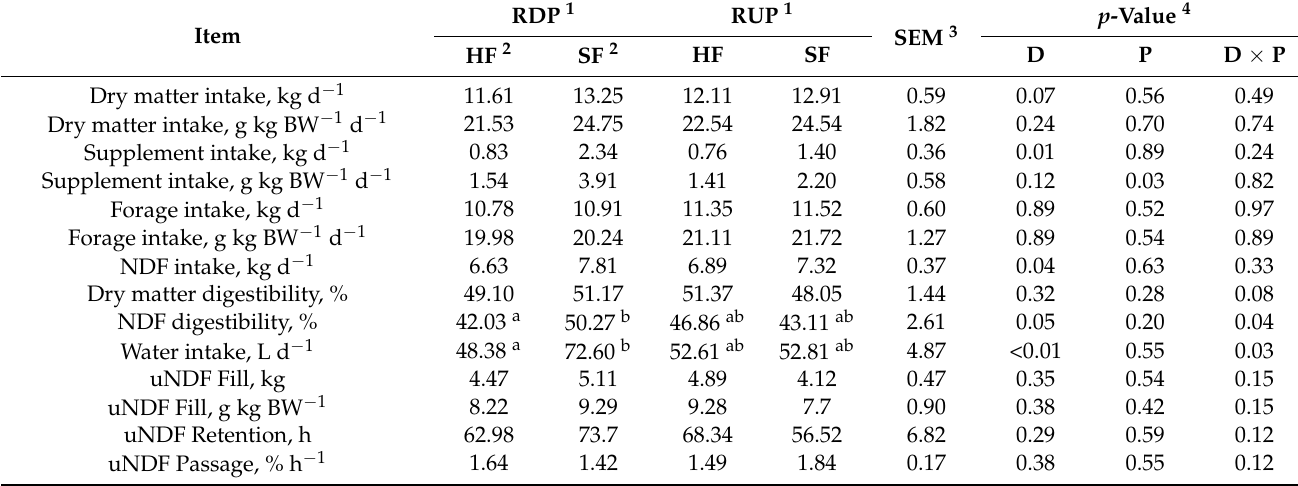
1 Protein type of rumen degradable protein (RDP) or rumen undegradable protein (RUP). 2 Delivery method of hand-fed (HF) or self-fed (SF). 3 Pooled standard error of the means presented. 4 Delivery (D): delivery method of HF vs. SF; protein (P): type of protein fed (RDP vs. RUP); and the interaction of delivery method and protein type (D × P). a,b Means that lack common superscripts differ for delivery × protein ( p <